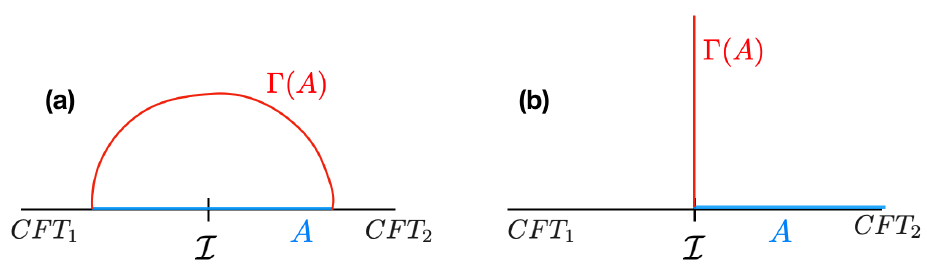
Figure 2 . (a) The entagling surface A is symmetric around the interface I , (b) The entagleing surface A is ends at the interface I